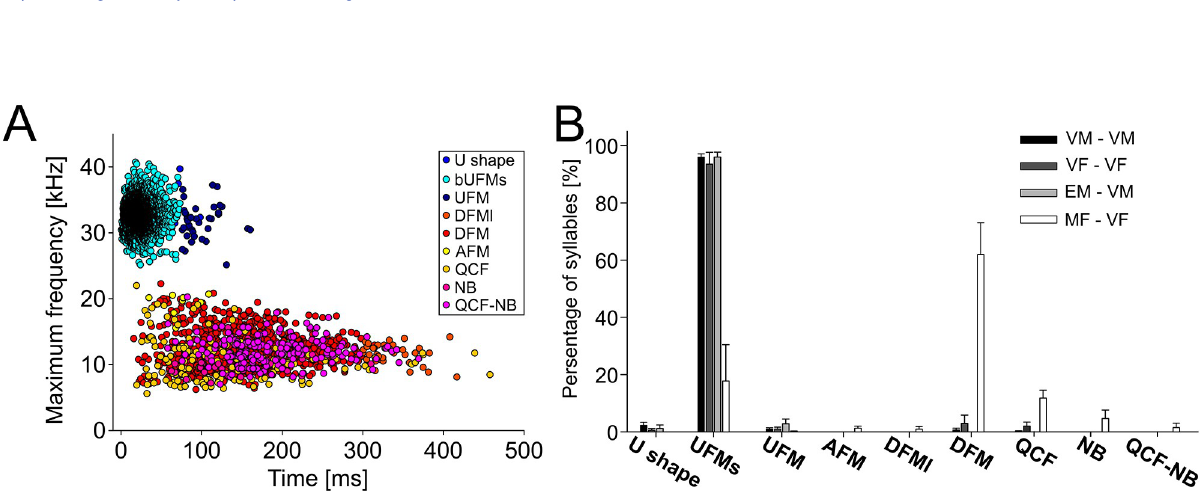
Fig 3. Relation between latencies of aggressive behavior and durations of aggressive behavior. Latencies of aggressive behavior and durations of aggressive behavior were negatively correlated ( ● , virgin male; ▲ , experienced male; ● , virgin female; ▲ , multiparous female; r s = -0.669; p < 0.001).